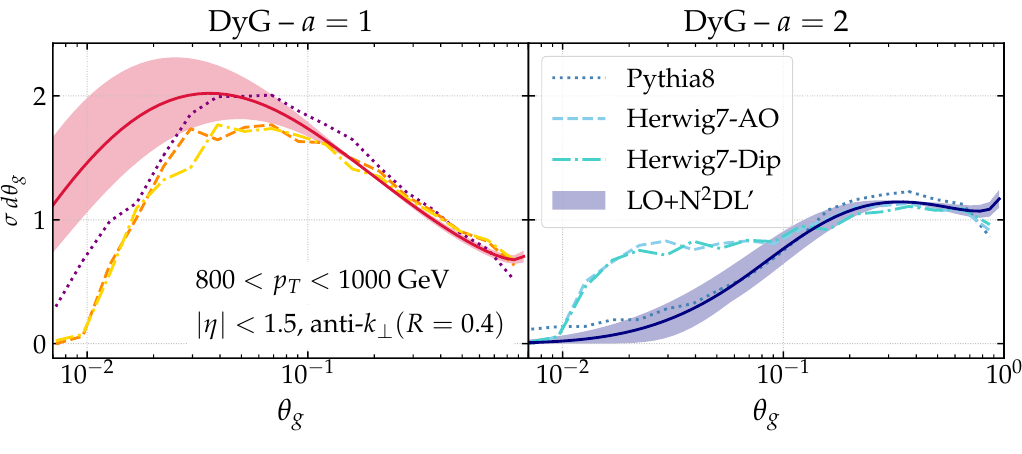
Figure 6 . Same as figure 5 but for θ g .